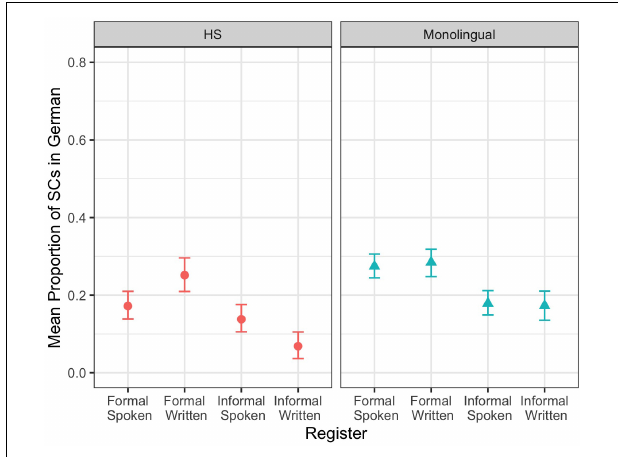
FIGURE 3 | Mean proportion of SCs in German by speaker group and register.